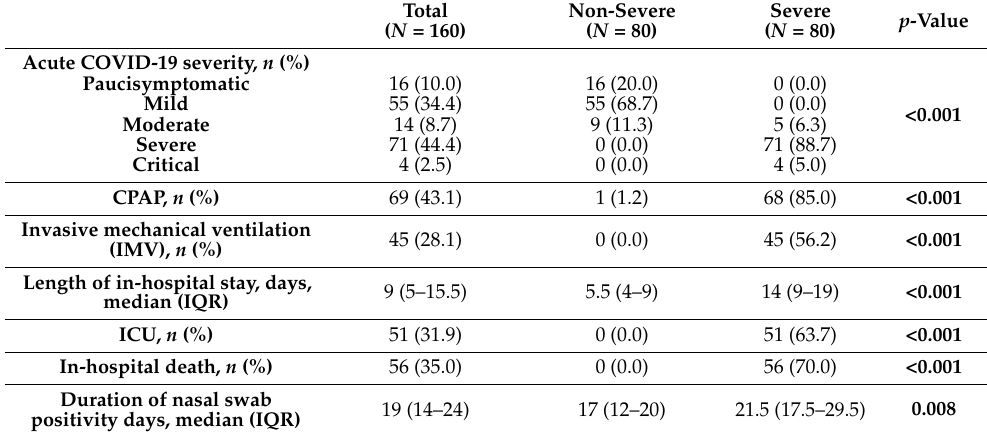
Table 2. Summary of clinical characteristics of enrolled patients. Stratification of the enrolled patients according to the disease severity, necessity for invasive and non-invasive ventilation, admission to the intensive care unit, the duration of hospitalization, death rate, and the duration of infection. Data are presented as either percentage or median and interquartile range. Results of the comparison between non-severe vs. severe patients are shown in the right column ( p -value). Significant results are shown in